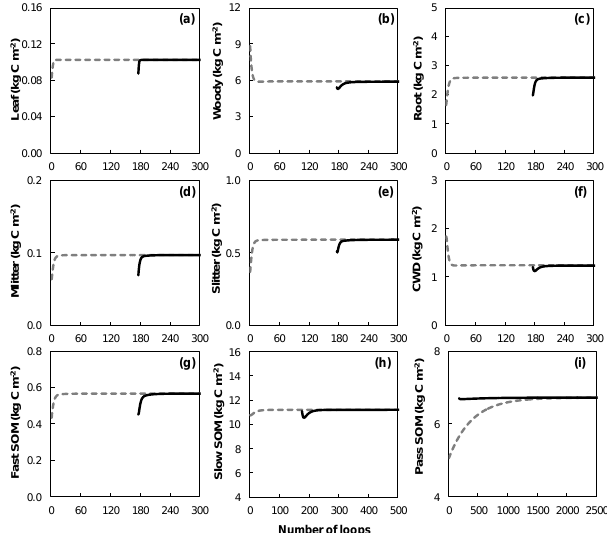
Figure 5. 722 Fig. 5. Coupled carbon–nitrogen simulations: carbon state trajecto- ries for all carbon pools at Harvard Forest site with different spin-up methods from traditional procedure (dotted gray lines) and with the SAS (straight black